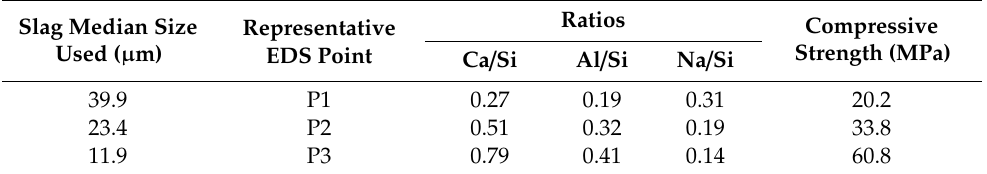
Table 9. Elemental composition and selected properties of AAMs produced under the conditions